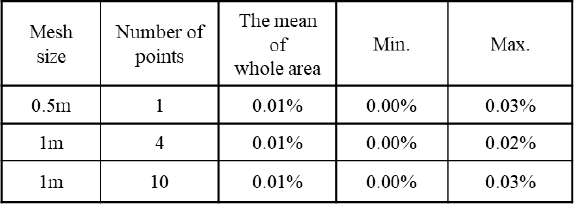
Table 3. Data missing rate in the preliminary experiment